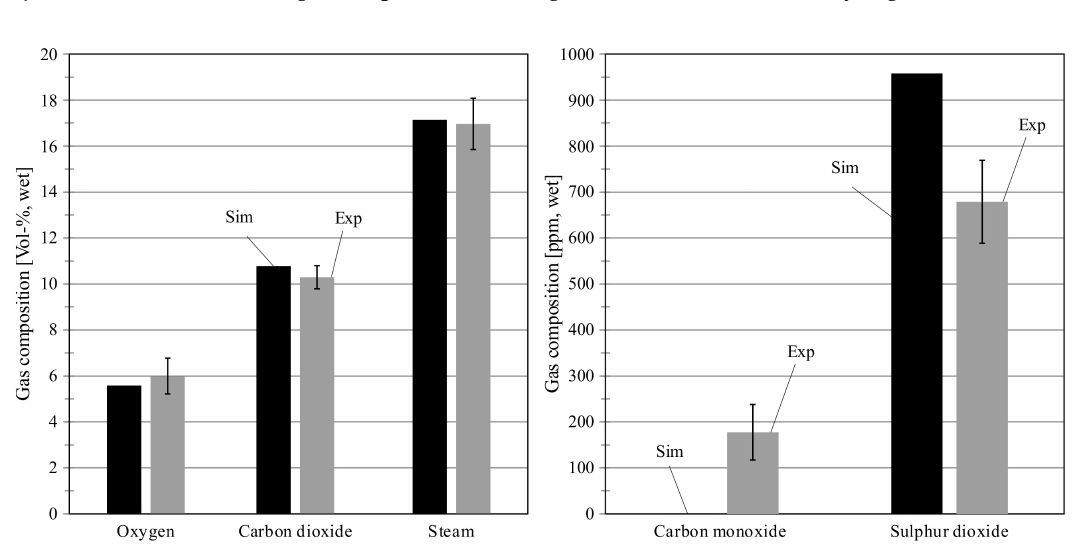
Figure 6. Flue gas composition (steady-state